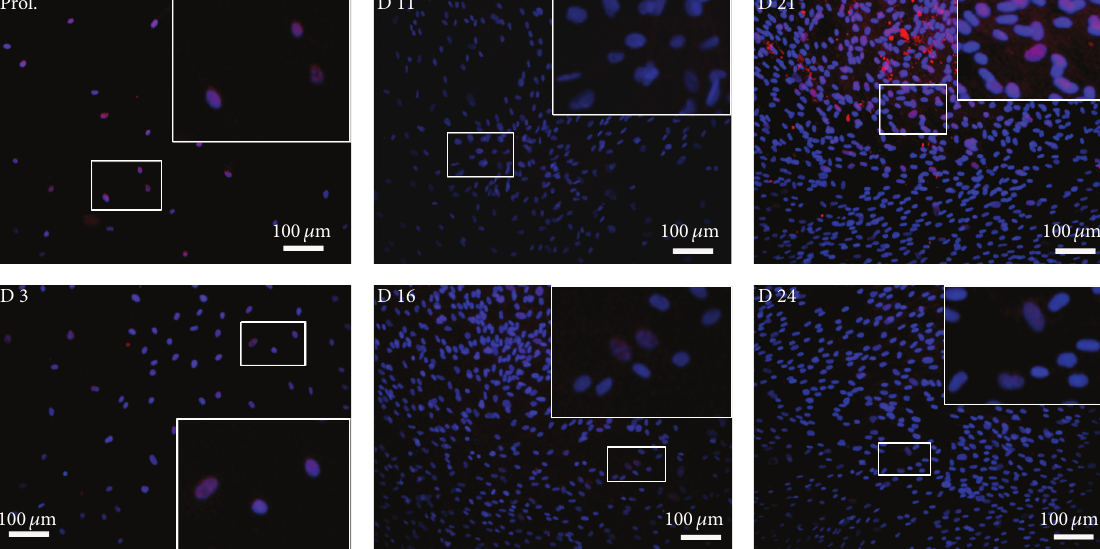
Figure 2: ATF5 expression levels during osteogenic differentiation of hADSCs. (a, b, c) Relative quantification of mRNA levels assessed by real-time PCR for ATF5 isoforms, conducted on RNA from hADSCs, either undifferentiated (proliferation) or differentiated (D 0–D 28). Proliferation group is used as reference for quantitation. The analysis of variance of both ATF5 isoforms relative expression levels indicates a statistically significant modulation during osteogenic differentiation ( 𝑝 < 0.001 ). Prol.